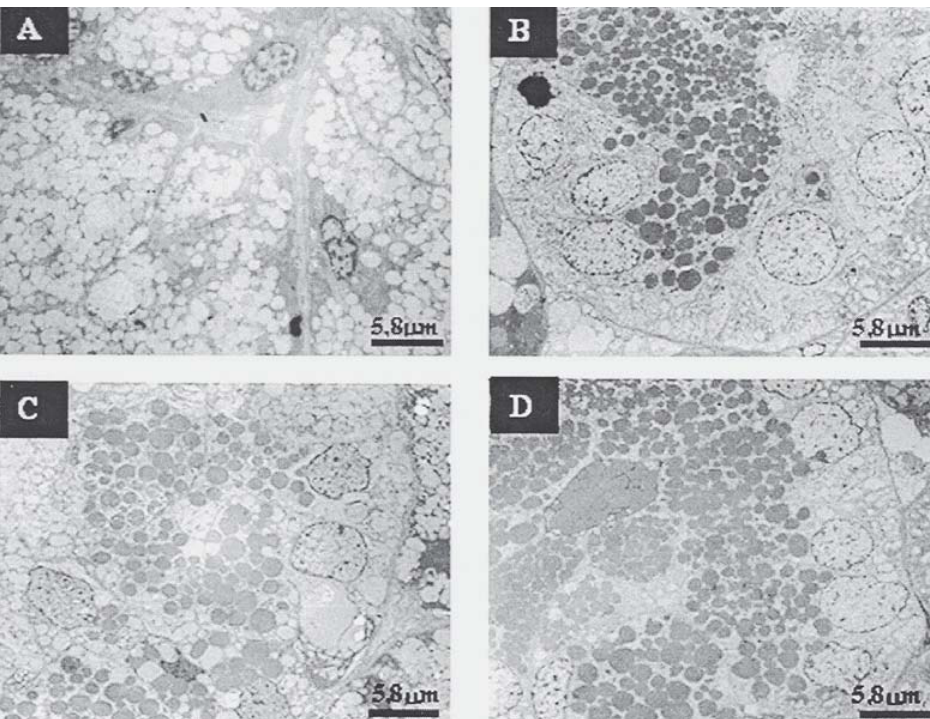
FIGURE 2- Transmission electron microscopy of submandibular gland tissues for each groups at 4 h. (A) Mucous cells from the irradiated group. (B) Serous cells from the irradiated group presenting greater degranulation than the mucous cells. (C) Serous cells from the sodium selenite group. (D) Serous cells from the sodium selenite/irradiated